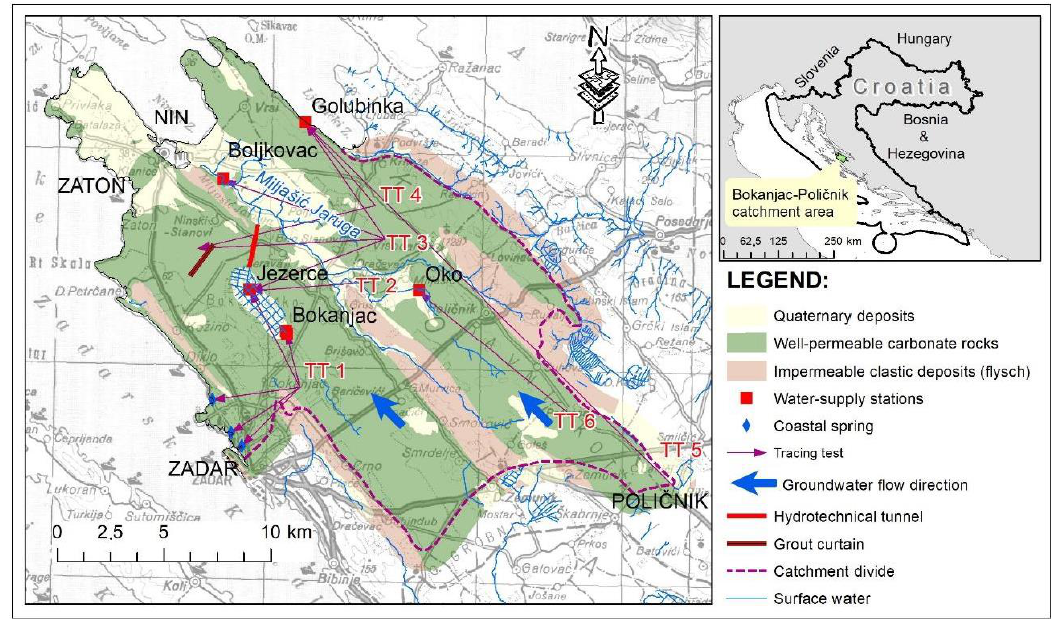
Figure 1. Hydrogeological map of the Bokanjac- Poličnik ca tchment area. Groundwater flow directions in the Bokanjac- Poličnik catchment area are parallel or subparallel to the geological structures in the southeast-northwest direction in two sepa- rate parts or flow lines, as proved by the tracing tests. The first flow line is on the northeast side of the flysch barrier from Poličnik to the northwest side of the catchment area follow- ing the geological structures. The majority of groundwater of this flow line flows towards the coastal spring Golubinka and the pumping station Boljkovac. Only after the zone where the flysch barrier ends, the groundwater flows perpendicular to the spread of the structures, towards the Jezerce pumping station. The second flow line is towards Bo- kanjačko Blato and further towards Boljkovac a nd to the northwestern part of the catch- ment area where groundwater diffusely discharges to the sea near Zaton and Nin. The natural conditions of surface water and groundwater dynamics have been par- tially changed by the construction of a hydrotechnical tunnel through which the flood waters of Bokanjačko Blato have been drained to the Miljušić Jaruga since 1963. This pre- vents the formation of a temporary lake in the area of Bokanjačko Blato. Prior to the con- struction of this facility, the area of Bokanjačko Blato was occasionally flooded and slowly emptied by sinking in the northwestern part of the field. With the construction of the tun- nel, the area of Bokanjačko Blato is no longer flooded, thus enabling permanent agricul- tural activity in this area. Irrigation and drainage canal systems have been built for this purpose. However, on the other hand, this intervention also changed the conditions of groundwater recharge, i.e., reduced the positive impact of infiltration of that surface wa- ters on the hydrogeological conditions in the aquifer. Almost all water supply facilities in the catchment area (Golubinka, Boljkovac, Jez- erce, Bokanjac) have temporary problems with saltwater intrusion. Because of that, the grout curtain was constructed in the mid-seventies of the last century downstream of the